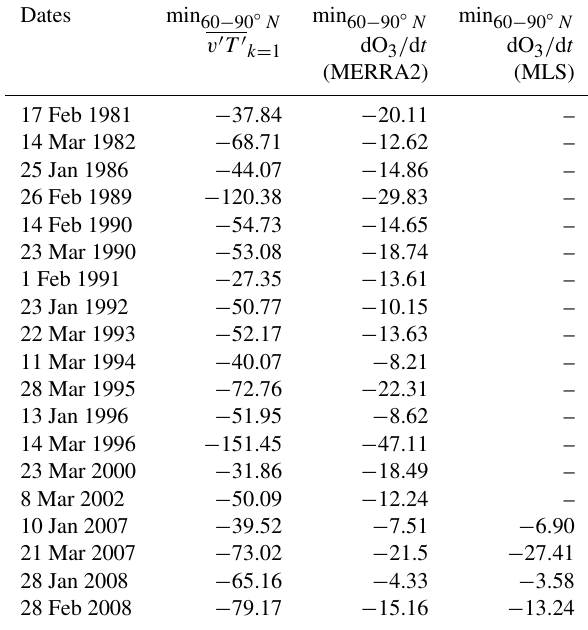
Table 1. Central dates of potential DWC events at 50 hPa and